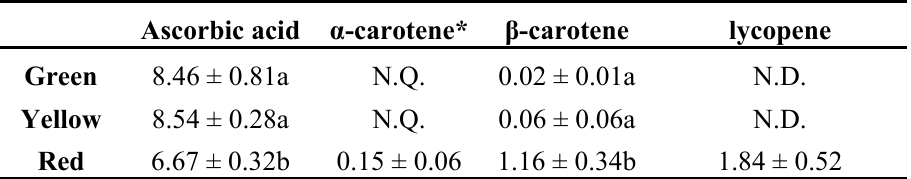
Mean values ± SD (n = 3) of mg/100 g of fresh weight. Means in columns for each berry followed by different letters differed significantly (p ≤ 0.05). N.Q.